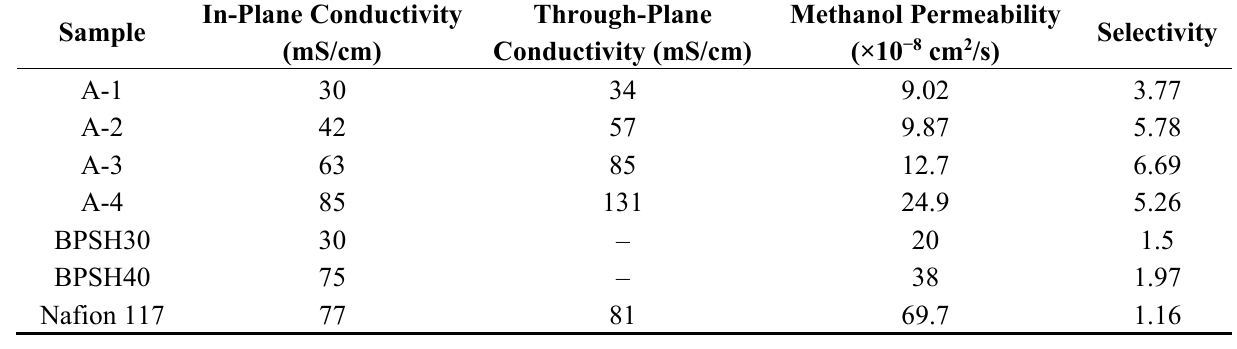
Table 2. Comparison of conductivity and permeability of PE-g-s-PAES and reference PEMs.